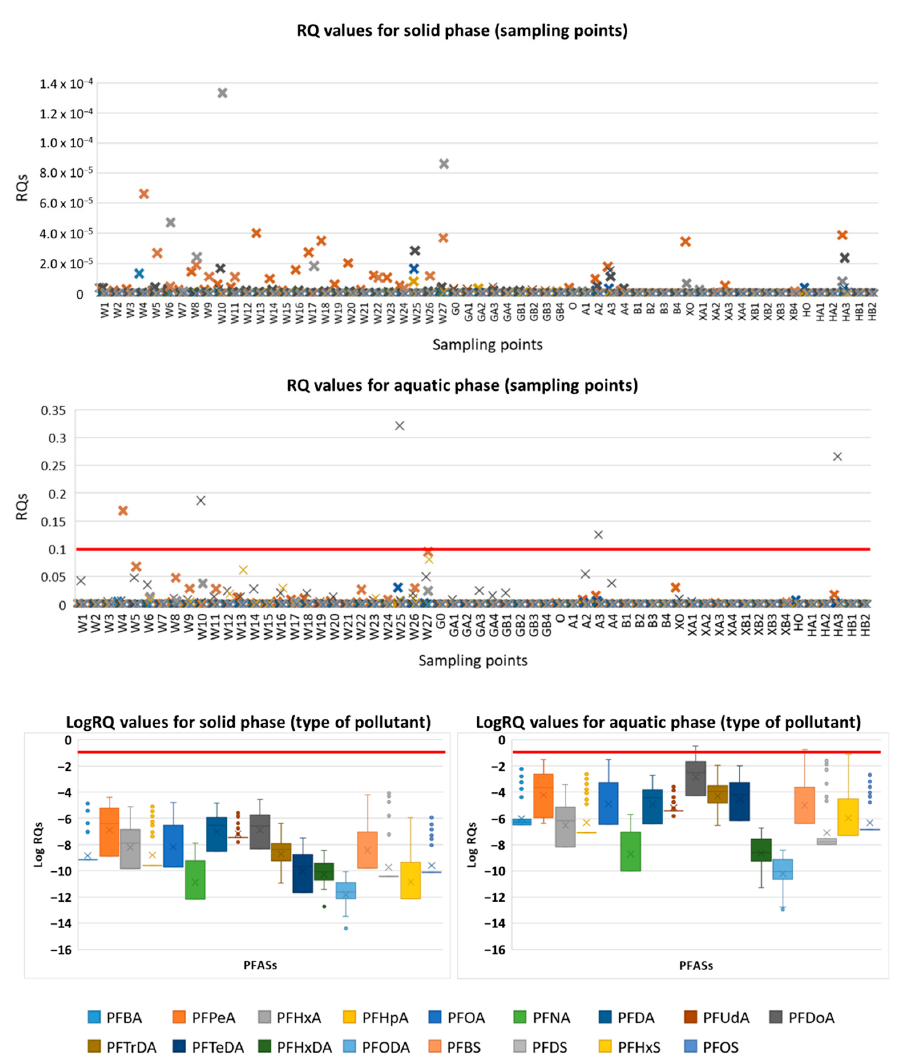
Figure 3. The environmental risk quotients (RQs) of PFASs compounds in the Gulf of Gdansk (the Vistula River: W1–W27; wastewater treatment plants-WTP I: G0–GB4, WTP II: O–B4, WTP III: XO–XB4, WTP IV: HO–HB2; red line indicates medium risk).